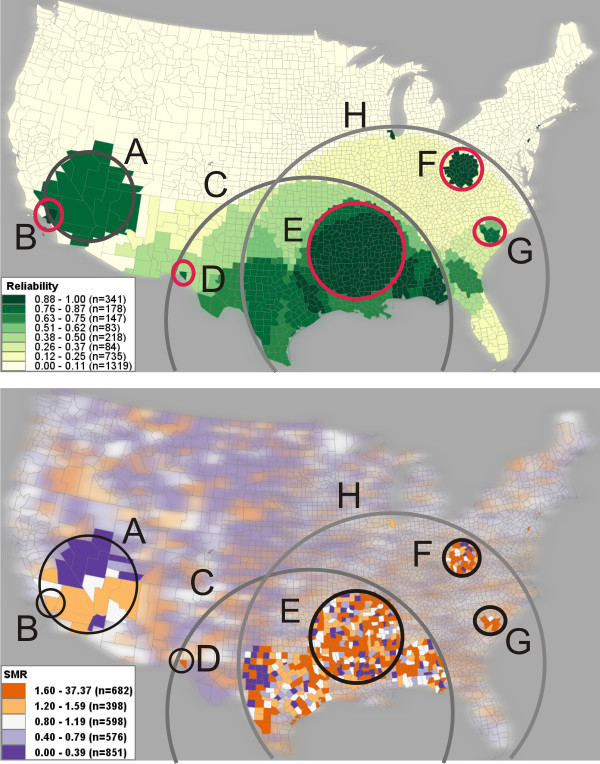
Visualization of reliability and SMR. Top: A reliability visualization of the eight SaTScan runs mapped in Figure 3. The reliability values are classified into eight categories (one category for each possible value); darker shading represents a higher reliability. Boundaries of the heterogeneous clusters (A, C, and H) and the core clusters (B, D, E, F, and G) marked in Figure 3 are also marked here for comparison. Bottom: A choropleth map of SMR filtered to show only those counties with a reliability score above '0.875' (the top two classes in Figure 4, top). Boundaries of the core clusters are marked. The clusters above are manually circled and labelled for illustration purposes.